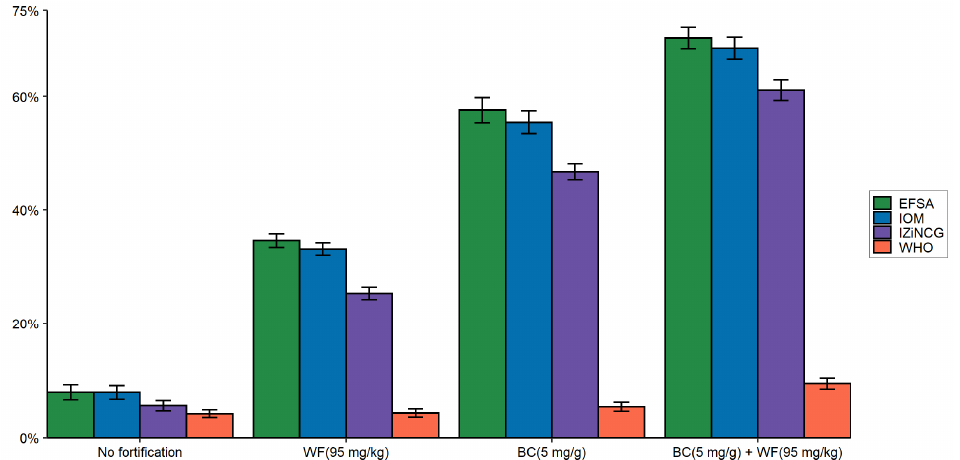
Figure 7. Prevalence ( ± SE) of zinc intake above the UL, considering the potential contribution of zinc fortification programs among children in Cameroon: estimated based on WHO, IZINCG, IOM, and EFSA UL reference values. EFSA, European Food Safety Authority; IOM, US Institute of Medicine; IZiNCG, International Zinc Nutrition Consultative Group; WHO, World Health Organization; WF, wheat flour; BC, bouillon cubes; UL, tolerable upper intake level